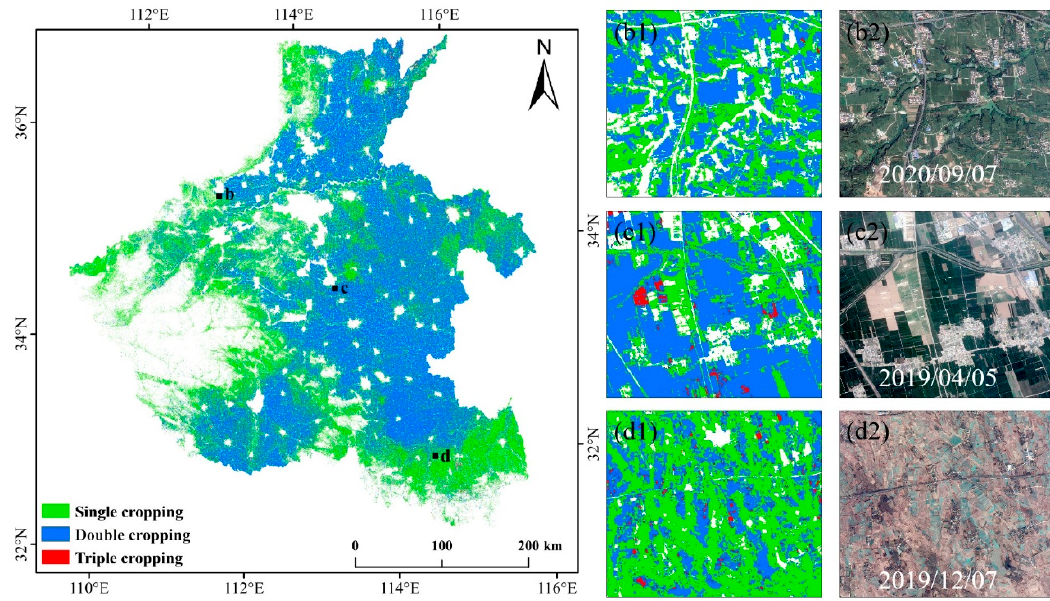
Figure 6. ( a ) Cropping intensity map with 10 m spatial resolution in Henan Province in 2020. ( b1 – d1 ) are zoom-in views of three randomly selected areas; ( b2 – d2 ) are the landscapes from Google Earth images. ( b1 ) and ( b2 ), ( c1 ) and ( c2 ), ( d1 ) and ( d2 ) correspond to b, c, d in ( a ), respectively. Image source: Image 2021 Maxar Technologies and 2021 CNES/Airbus. Image date: Identified in the picture. Color composite: RGB (red, green, blue).